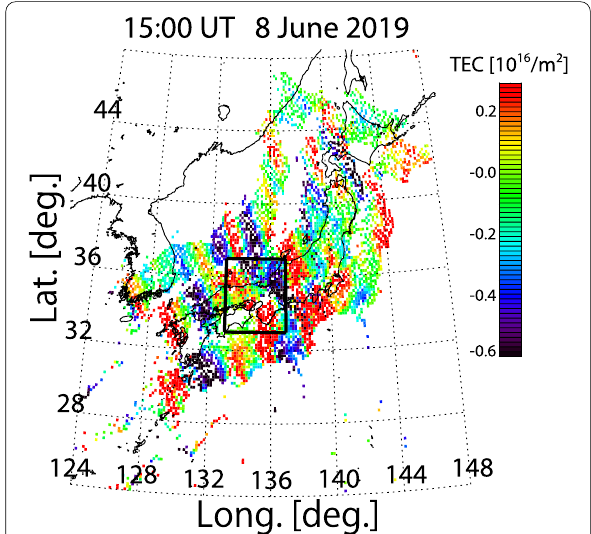
Fig. 1 Two-dimensional map of detrended TEC at 15:00 UT on 8 June (00:00 LT on 9 June) 2019. TEC data within an area enclosed by solid lines (133.0°–137.0° E and 33.0°–37.0° N) were used to estimate MSTID activity and horizontal propagation direction and velocity of